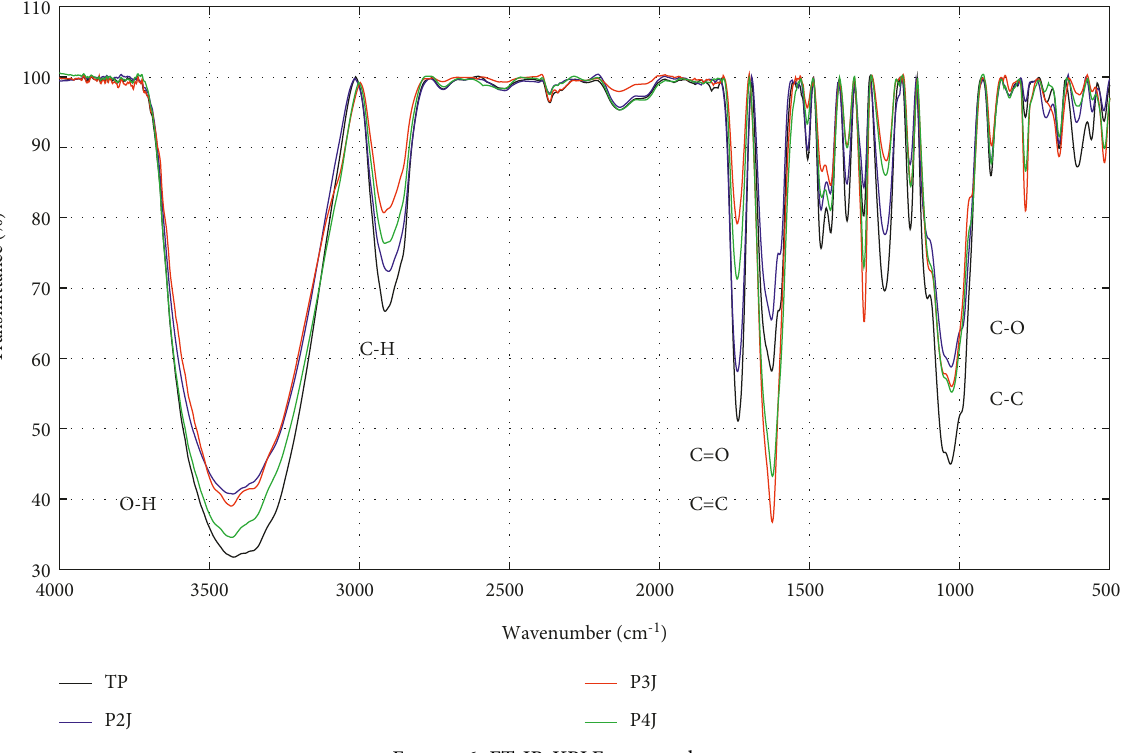
Figure 6: FT-IR KPLF test